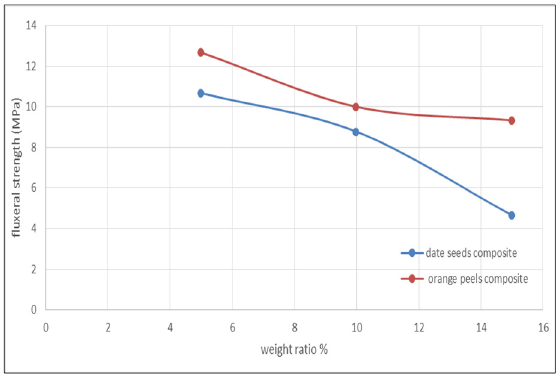
Fig .9. Flexural strength of natural composite material in various weight ratios.